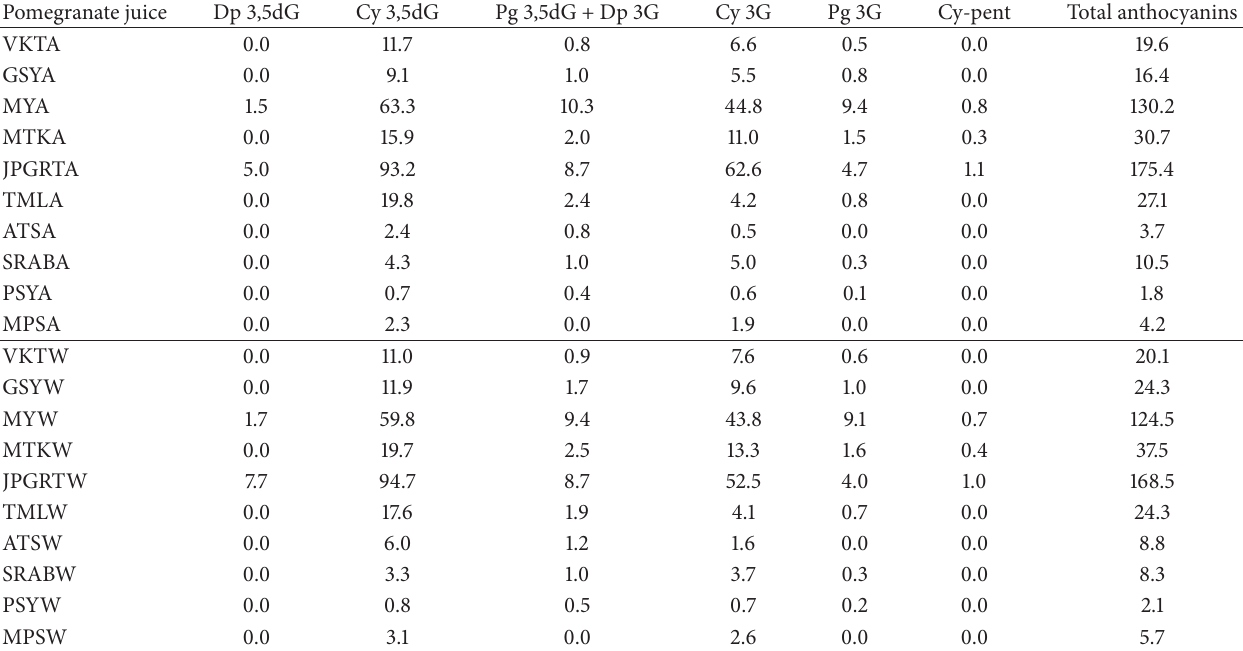
Table 2: Contents of individual anthocyanins (mg/L) in pomegranate